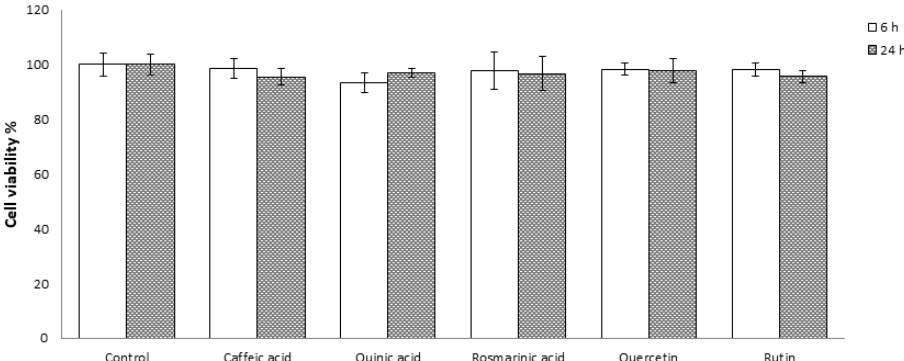
Figure 3. Caco-2 cell viability (%) when exposed to 0.1 mg/mL of tested compounds for 6 and 24 h.